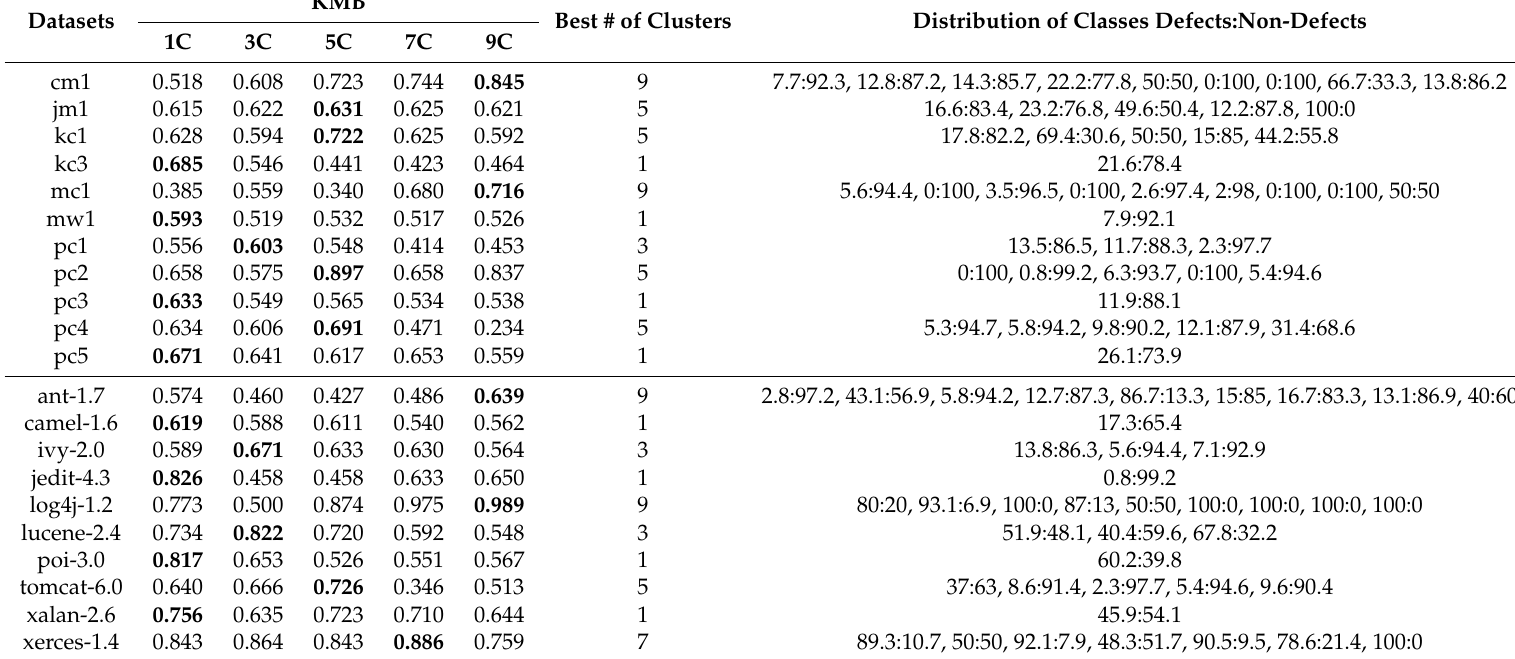
Table 3. G-mean results of two-folds cross-validation for the proposed approach based on the basic classifiers.